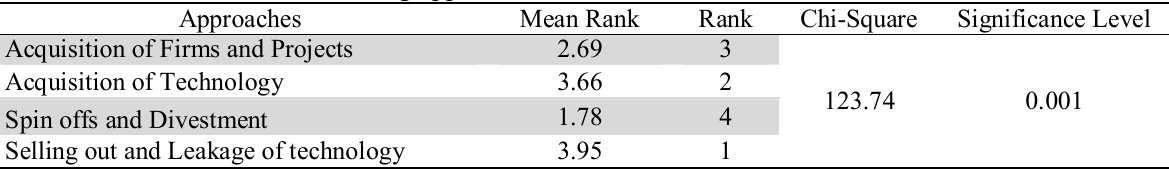
Results of Friedman test for ranking